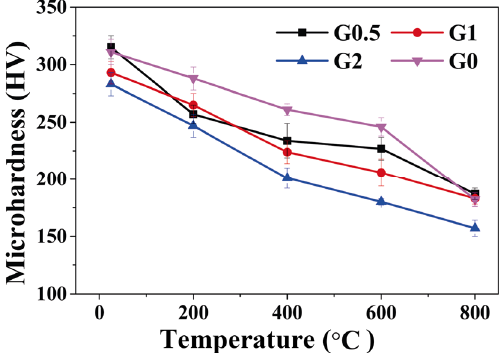
Fig. 10 Micro hardness of the nickel alloy matrix composites at different temperatures.